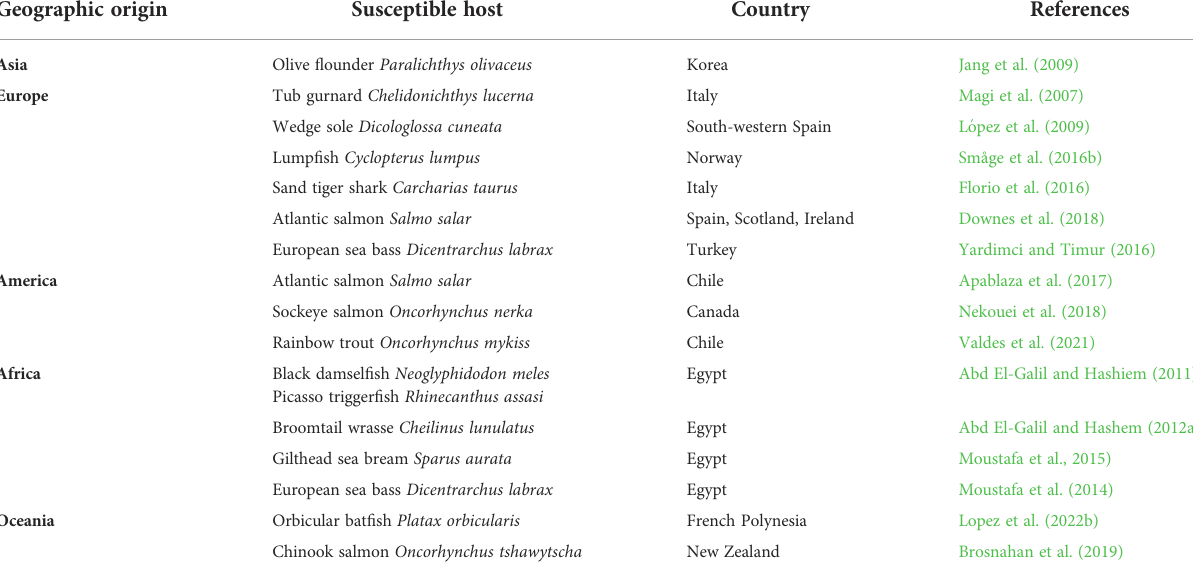
TABLE 2 Susceptible host species for Tenacibaculum maritimum and the respective geographic origin (updated since